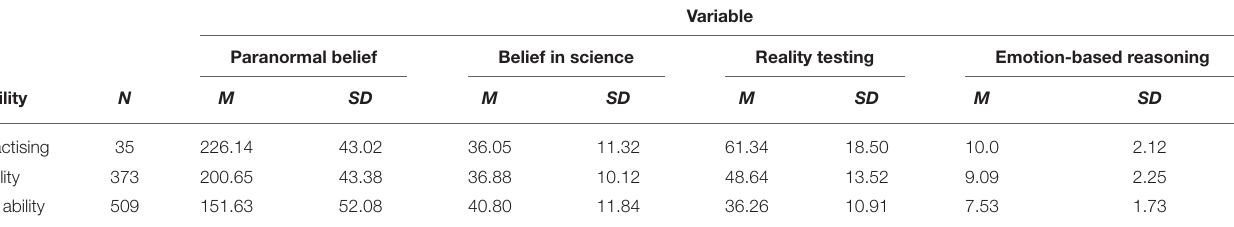
TABLE 2 | Means and standard deviations for paranormal belief, reality testing, emotion-based reasoning, and belief in science as a function of ability.